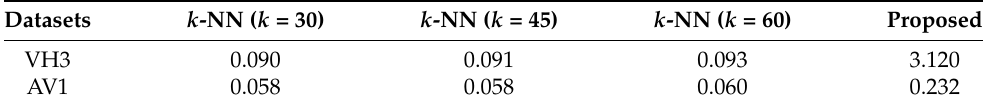
Table 2. Average processing time (in seconds) of neighbourhood selection techniques for each building.